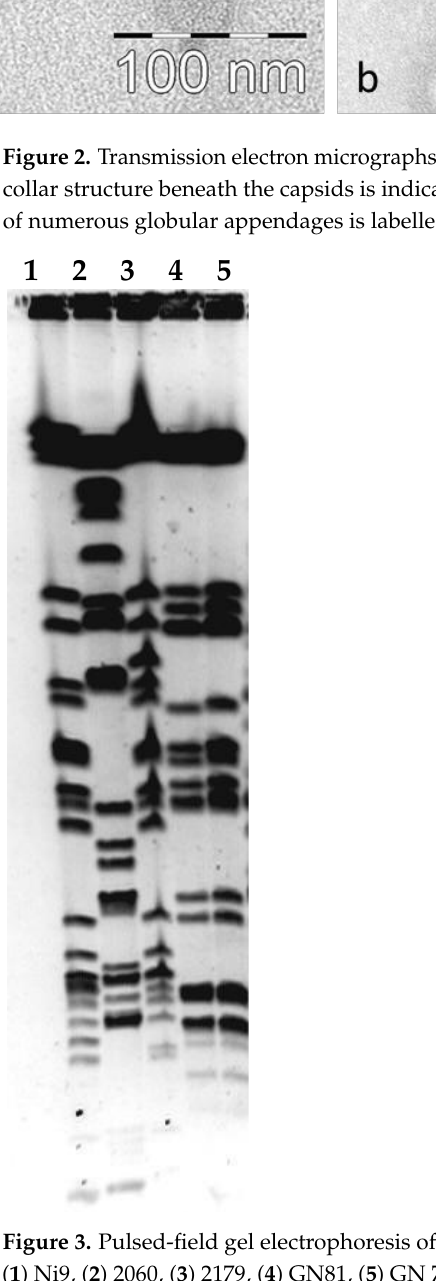
Figure 2. Transmission electron micrographs of K. pneumoniae phages LASTA ( a ) and SJM3 ( b ). A thin collar structure beneath the capsids is indicated by the arrows and a distal disc structure composed of numerous globular appendages is labelled with triangles.